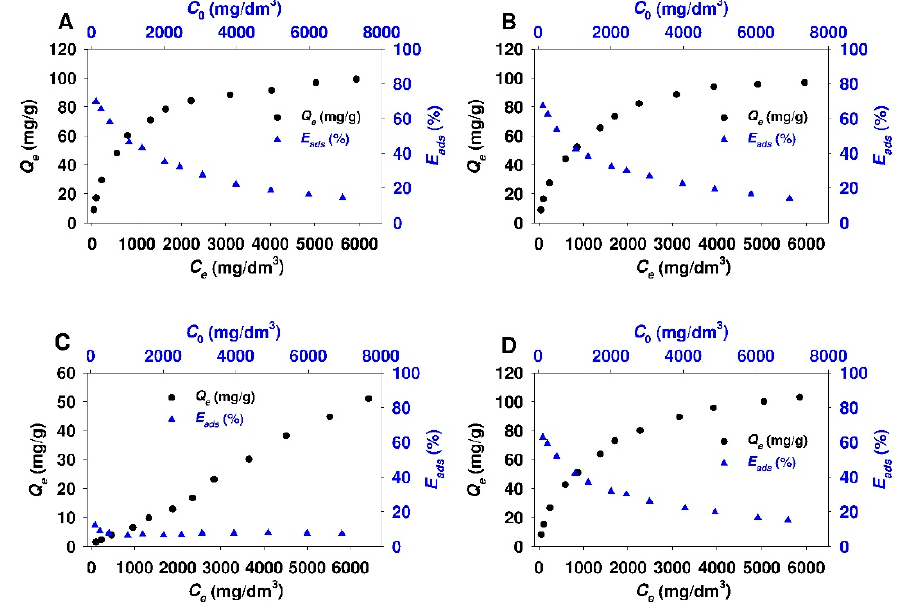
Figure 7. Adsorption isotherms and adsorption efficiency of 18 β -glycyrrhetinic acid onto: ( A ) Aer-AP, ( B ) Aer-15-MAP, ( C ) Aer-DMAP, and ( D ) Aer-AEAP colloidal silicas.